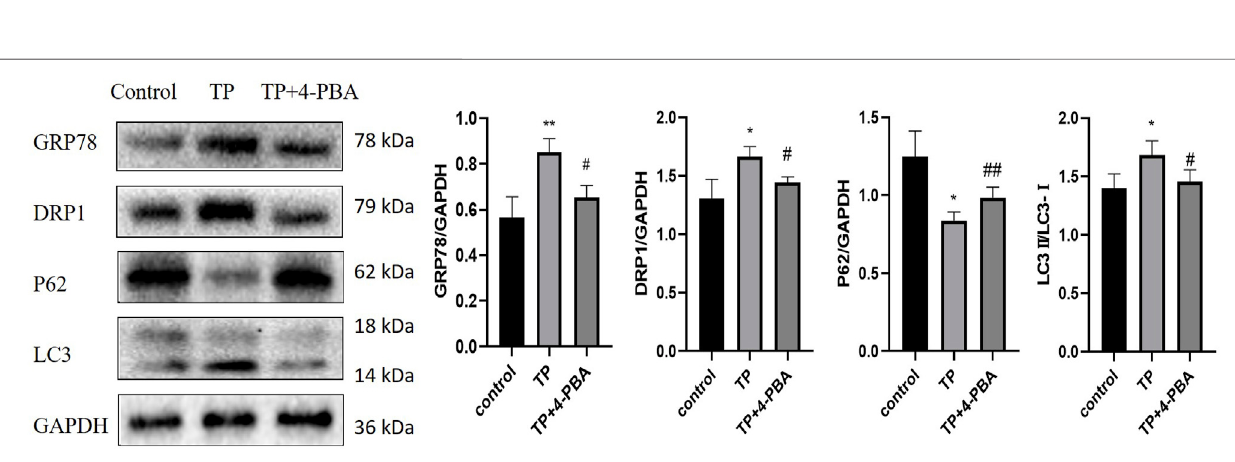
FIGURE 5 | of HepaRG cells by inhibiting mitophagy by Midivi-1. (H) The effect of 4-PBA on the expression of GRP78 in cells. (I) The effect on HepaRG cell viability by inhibitingERSby4-PBA. (J) TheeffectonALT,AST,andLDHindexesincellsupernatant byinhibiting ERSby4-PBA.Comparedwiththecontrolgroup, *p < 0.05,**p < 0.01, ***p < 0.001 ; compared with the TP group, # p < 0.05, ## p < 0.01, ### p <